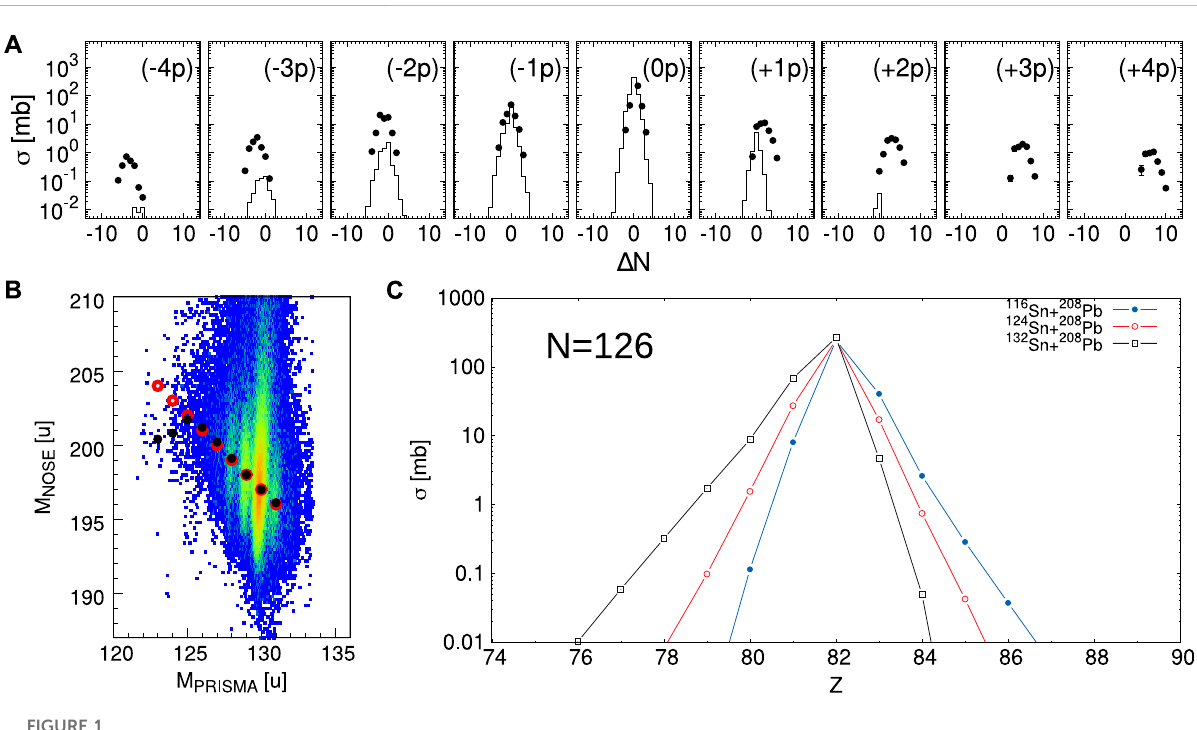
FIGURE 1 (A) Total experimental cross section for the 40 Ar+ 208 Pb system, at beam energy E lab = 6.4 MeV/A (points), and the GRAZING calculations with neutron evaporation (solid line), fi gure is adapted with permission from [18] (B) Mass-mass correlation matrix of Te isotopes detected in PRISMA and the heavy partner detected in coincidence with NOSE for the 197 Au+ 130 Te system. The red circles indicate the centroids of the correlated masses of the primary neutron transfer channels, the black dots indicate the experimental centroids as derived from the fi ts of their projections [47] (C) GRAZING calculations for the 116 Sn (stable), 124 Sn (the most neutron-rich stable) and 132 Sn (neutron-rich) projectiles on the 208 Pb target at the beam energy 20% above the Coulomb